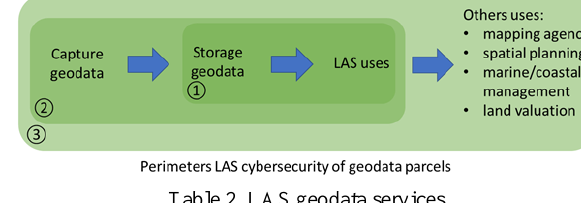
Table 2. LAS geodata